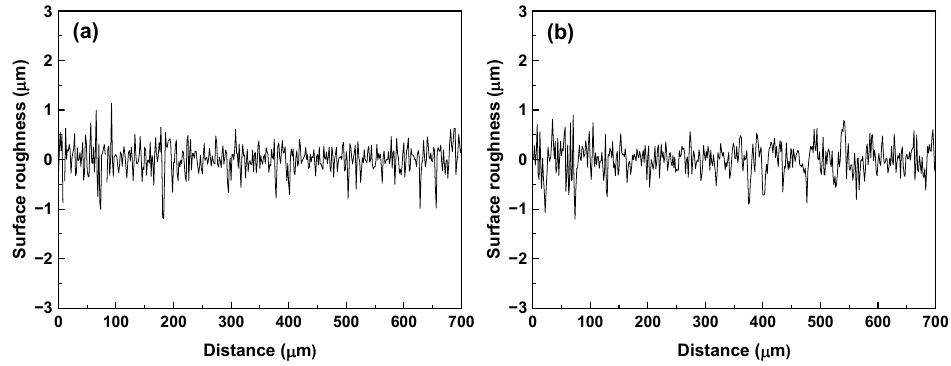
Figure 3. Surface roughness profiles of SG tubes: ( a ) Alloy 600 and ( b ) Alloy 690.